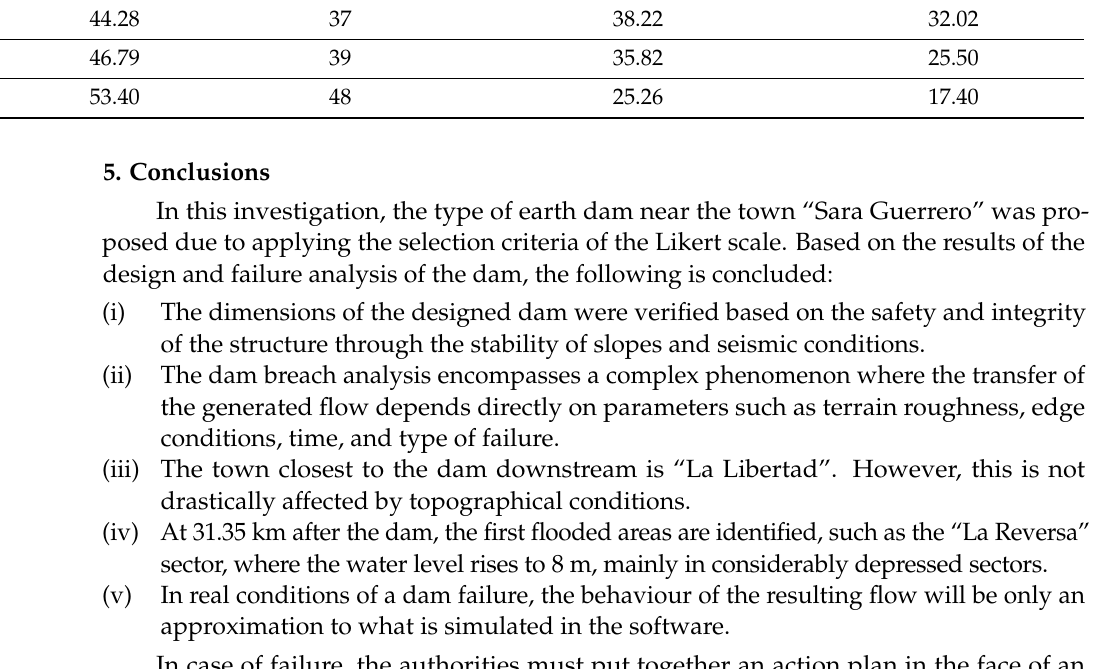
Table S4. Prevention/mitigation